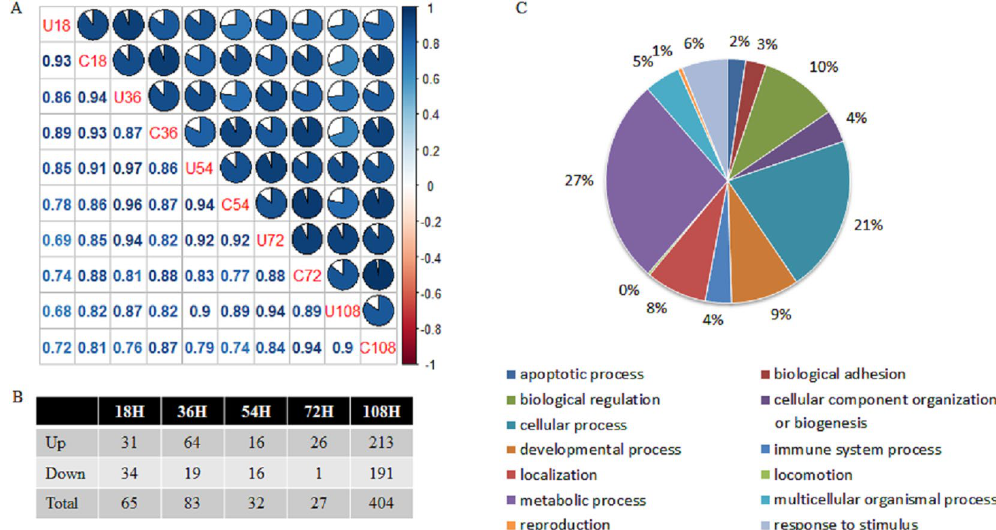
Figure 4. Differentially expressed genes in host-pathogen interactions. ( A ) Pearson correlation coefficients of gene expression profiles among samples. ( B ) Summary of genes with differential expression profiles between samples at different time points. ( C ) Functional classification of differentially expressed genes.